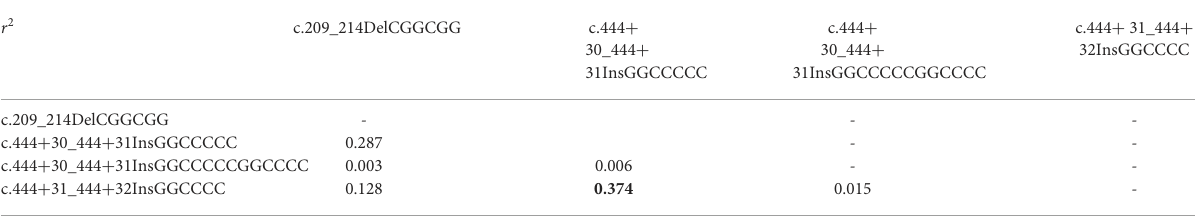
TABLE 2 Linkage disequilibrium (LD) among genetic polymorphisms of the SPRN gene in